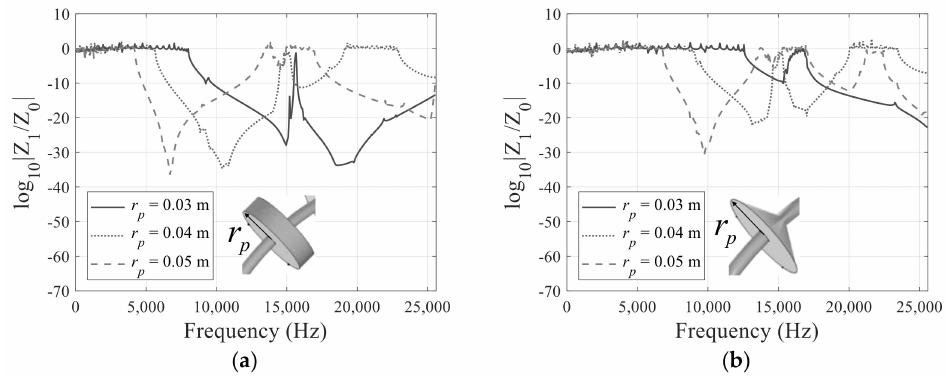
Figure 18. Frequency response results of ( a ) the round cylindrical metamaterials and ( b ) the round conical metamaterials.